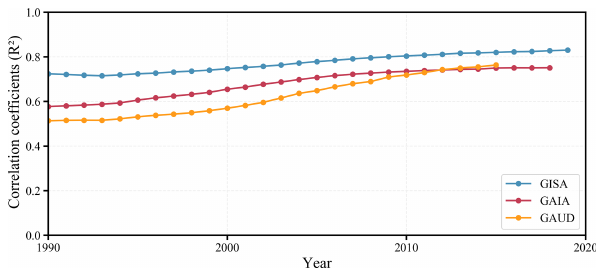
Figure 6. The correlation coefficients of the ISA fraction between CLCD and three thematic datasets for each year. ISA fraction was aggregated within the 0.05 ◦ by 0.05 ◦ spatial